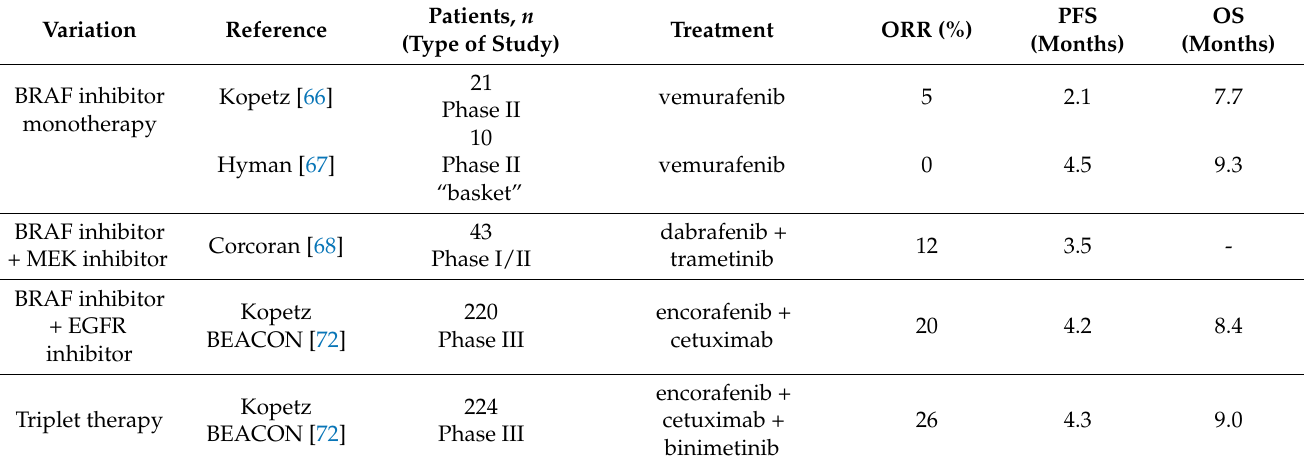
Table 2. BRAF inhibitors in metastatic colorectal